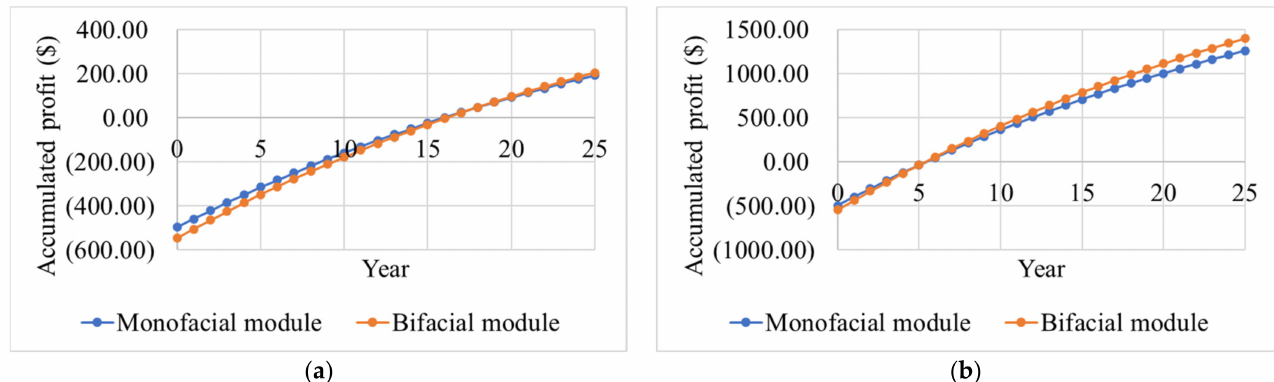
Figure 2. Accumulated profit of two types of solar modules: ( a ) SMP only; ( b ) SMP and REC. SMP: System Marginal Price; REC: Renewable Energy Certificate.